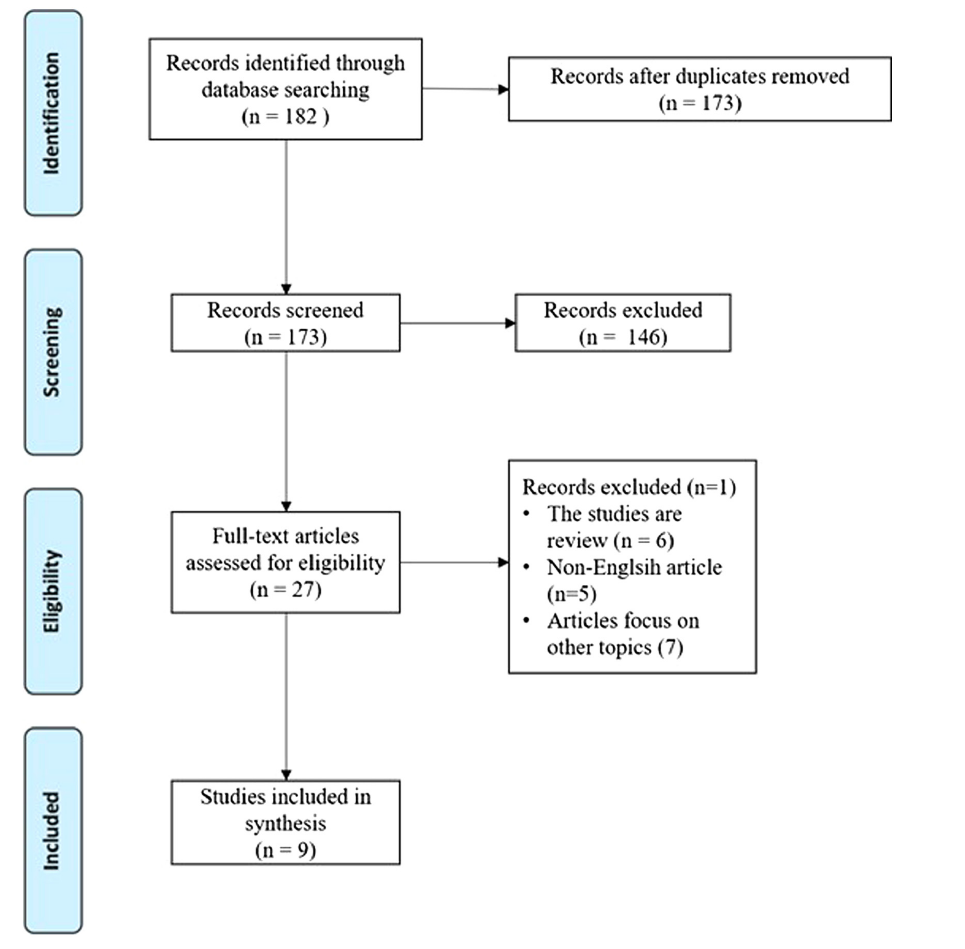
Figure 2. Preferred reporting items for systematic reviews and meta-analysis